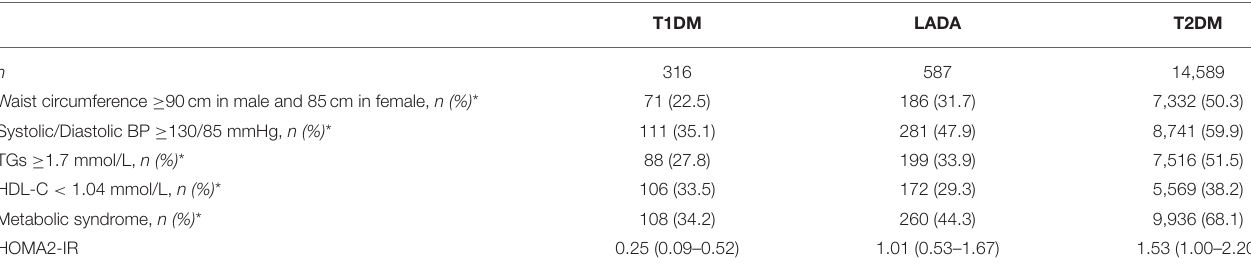
TABLE 3 | Number and percentage of patients with metabolic abnormalities by type of